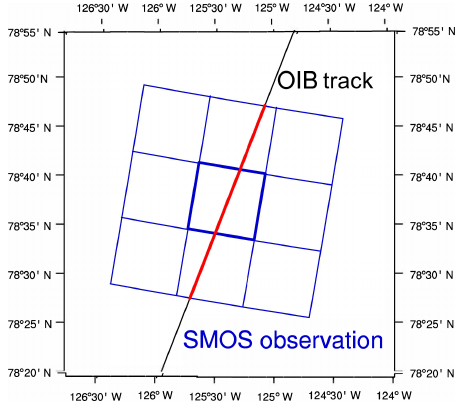
Figure 2. Data match between OIB and SMOS data. SMOS TB product is provided on the 12.5km EASE grid (shown by blue rect- angular cells). However, the inherent resolution of SMOS TB is of about 40km. The red and black line represents the OIB track. Therefore, in order to accommodate the resolution differences, OIB samples that reside within the nine cells (red) are considered to be of equal contribution to the TB value at the central EASE grid cell (outlined by the thick blue